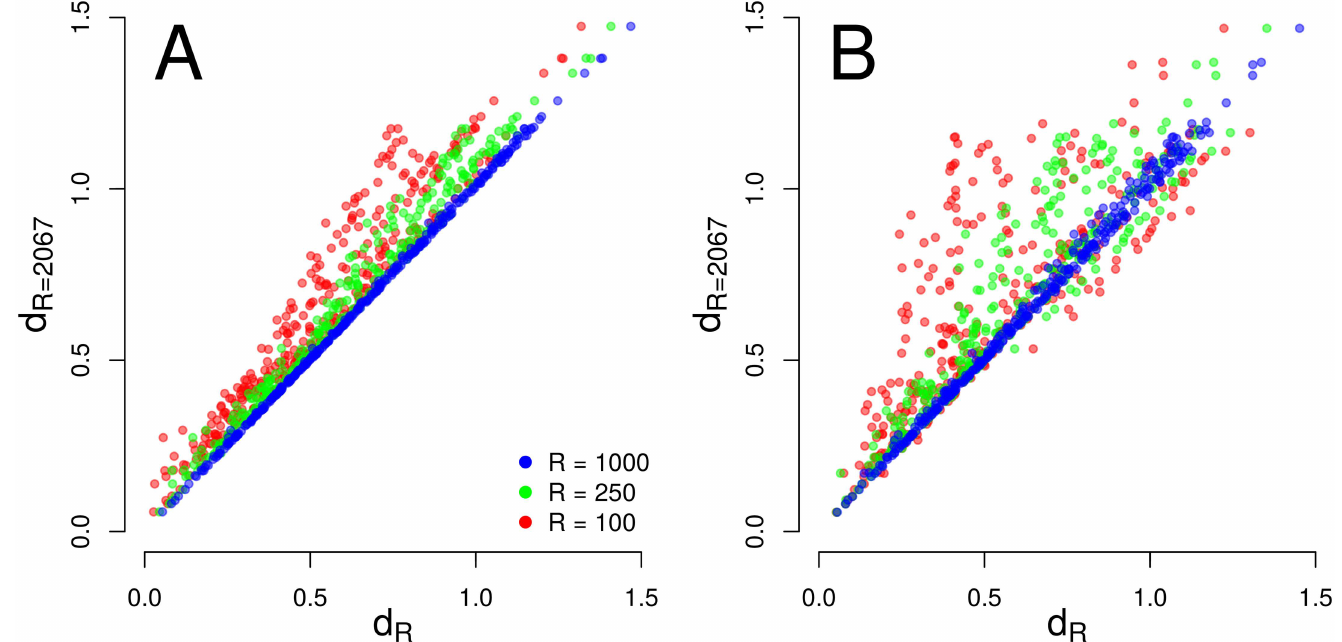
Fig 11. Dependence of NRAD distances d R on MaxRank R . Co-ordinatesare distances d R between all 26 (cid:1) (26 − 1)/2 = 325 NRAD pairs of the 26 GlobalPatterns samples at three different values of R . If the distanceof an NRAD pair is the same for both R , the point lies on the diagonal.(A) MaxRank normalization; (B) cutoff